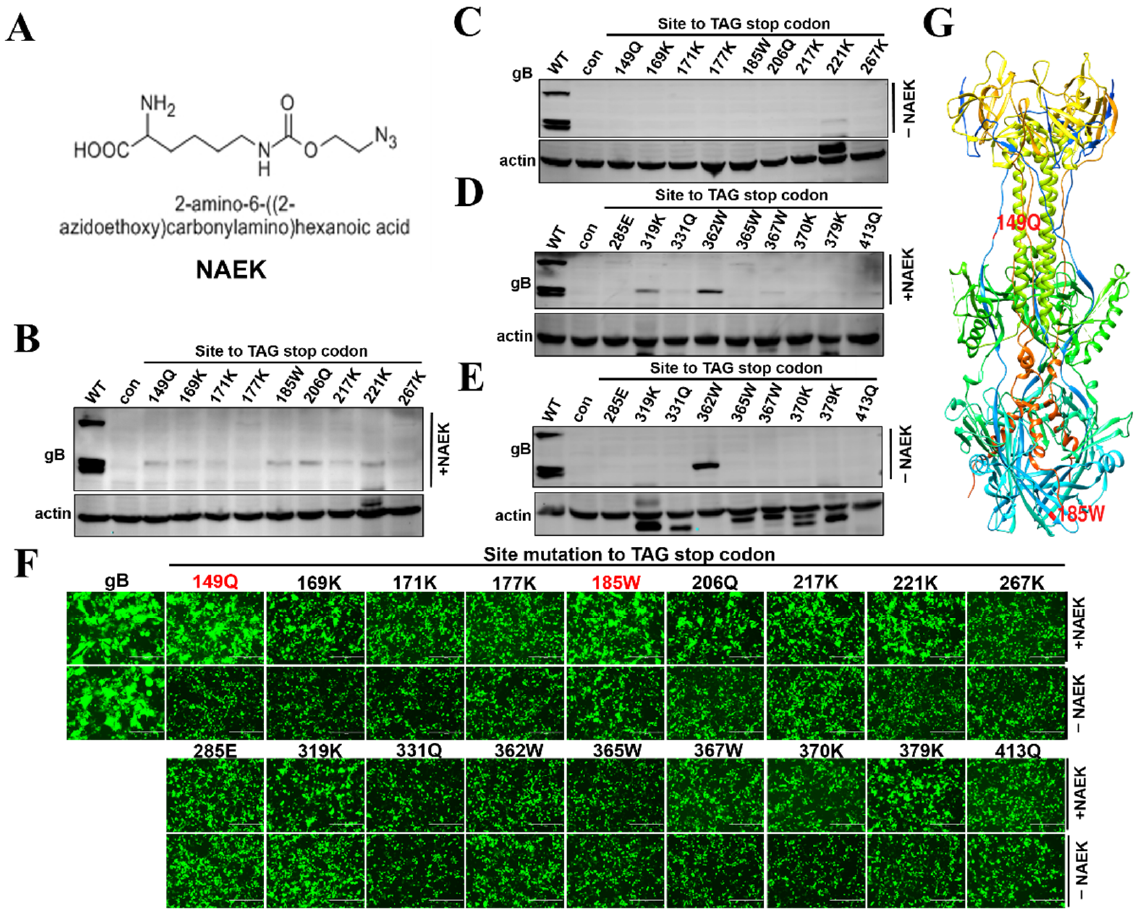
Figure 2. Evaluation of UAA site-specific incorporation for potential PRV gB PTC sites. ( A ) Chemical structure of N ε -2-azideoethyloxycarbonyl-L-lysine (NAEK). ( B , D ) HEK293T cells were co-trans- fected with GCE machinery and indicated gB-PTC plasmid; 6 h later, the fresh medium replaced the supernatant in the presence of 1 mM UAA (NAEK). Western blot was performed to analyze the UAA-dependent read-through efficacy of PTC harboring gB mutants in the presence of 1 mM UAA (NAEK) or ( C , E ) without UAA. β -actin was used as an internal control. ( F ) Cell-to-cell fusion assay was used to evaluate the read-through efficiency of PTC harboring gB mutants. RK13 cells were co- transfected with MbpylRS/tRNA Pyl , GFP, gD, gH, gL, gB, or its mutants, and 6 h later the superna- tant was replaced by fresh medium supplemented with 2% FBS in the presence of 1 mM UAA (NAEK), or not. Fluorescence microscopy was used to analyze the read-through efficacy by indicat- ing gB mediated cell fusion analysis at 48 h after transfection; the scale bar = 400 µm. The red labeled PTC constructs were used further study. ( G ) The corresponding position of 149 and 185 mutation points in the gB crystal structure.